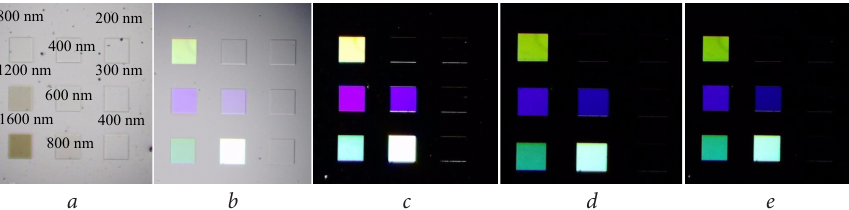
Fig. 4. Reflected light from structures of the imprint: a – Top illumination and period of each square; b – Top and side illumination under 30°; c – Side illumination under 30°; d – Side illumination under 30°– TM mode; e – Side illumination under 30° – TE